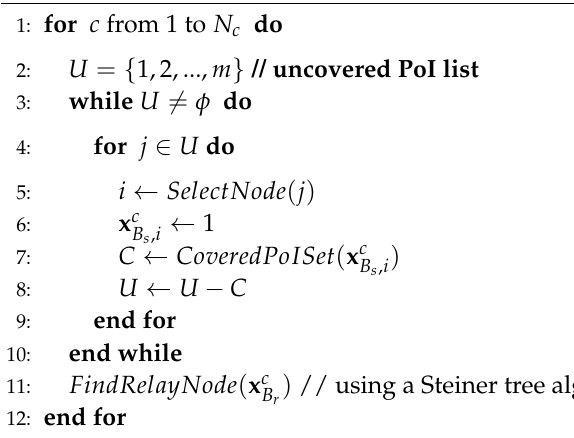
Algorithm 3 Initialization of the bat